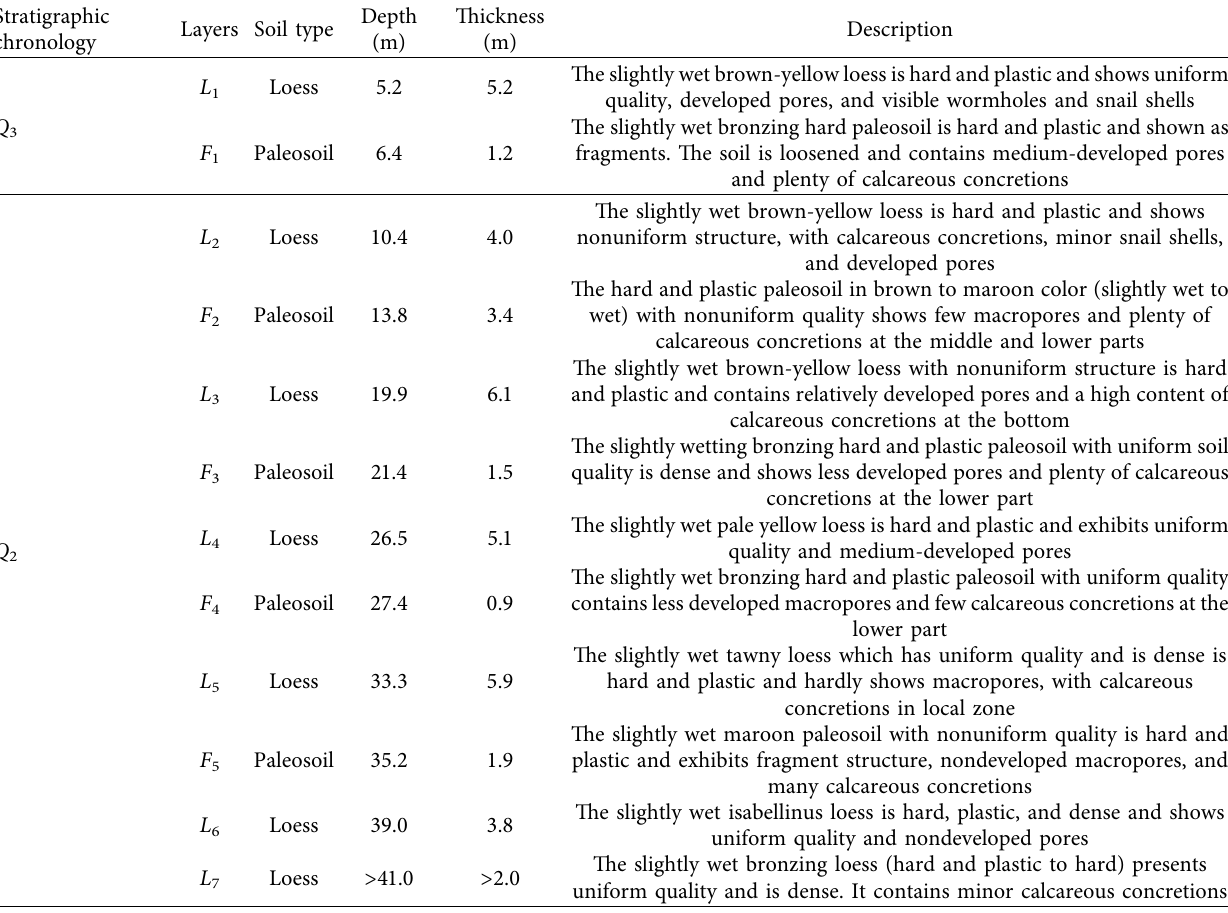
Table 5: Layout of soil layers.